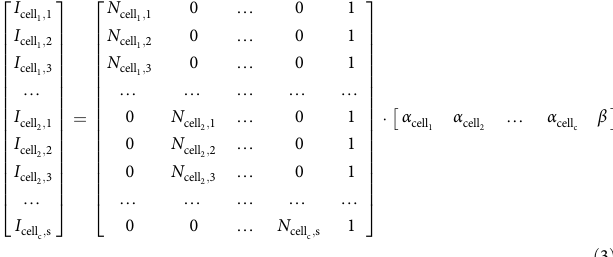
For visualization in Fig. 2c, we controlled the false discovery rate (FDR) among network links at 0.1% using a bootstrapping approach to calculate the 99.9% con fi dence interval of correlation coef fi cients after randomizing the data set. To that end, the cell lines in the metabolome data set were randomized by resampling 100 times with replacement, and pairwise Spearman correlation coef fi cients were calculated for each randomized data set. Correlation coef fi cients yielding a 99.9% con fi dence interval (0.1% FDR) were obtained from the pooled list of absolute correlation coef fi cients by fi nding the smallest correlation coef fi cient that exceeds the maximum value among 99.9% lowest correlation coef fi cients). Measurement of glucose and lactate exchange rates . A complete description of the experiments and techniques used to determine glucose uptake- and lactate secretion rates can be found in Supplementary